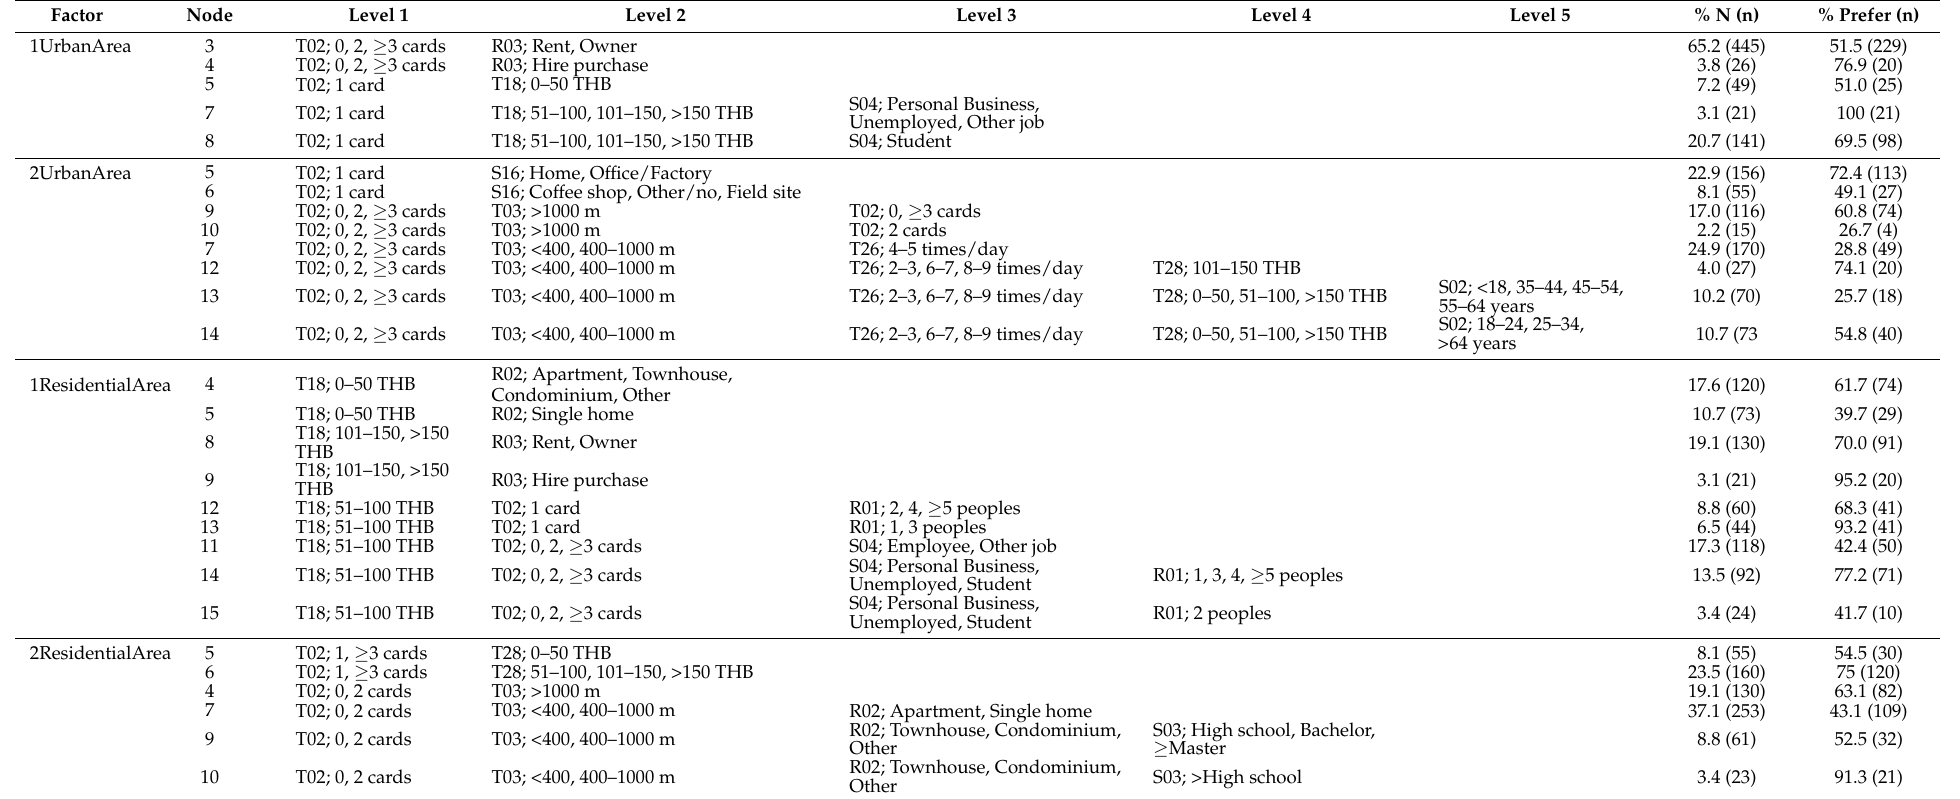
Table 5. Relevant segmentation of attitudes toward residential location areas and the decision rules for terminal